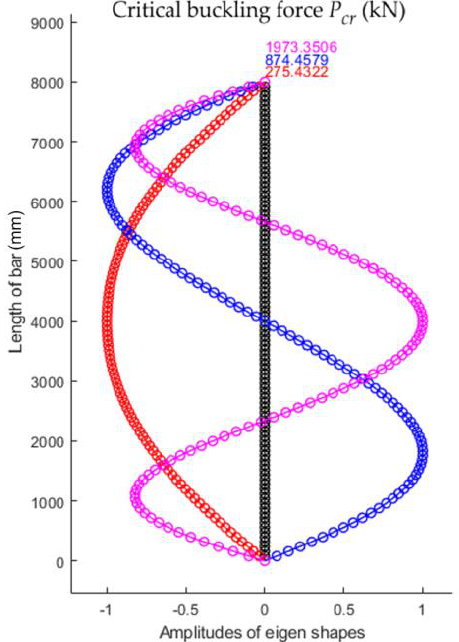
Figure 20. The first three eigenshapes of stability loss and corresponding values for the critical buckling forces for the bar with triangular variation in the second moment of inertia along the bar axis.